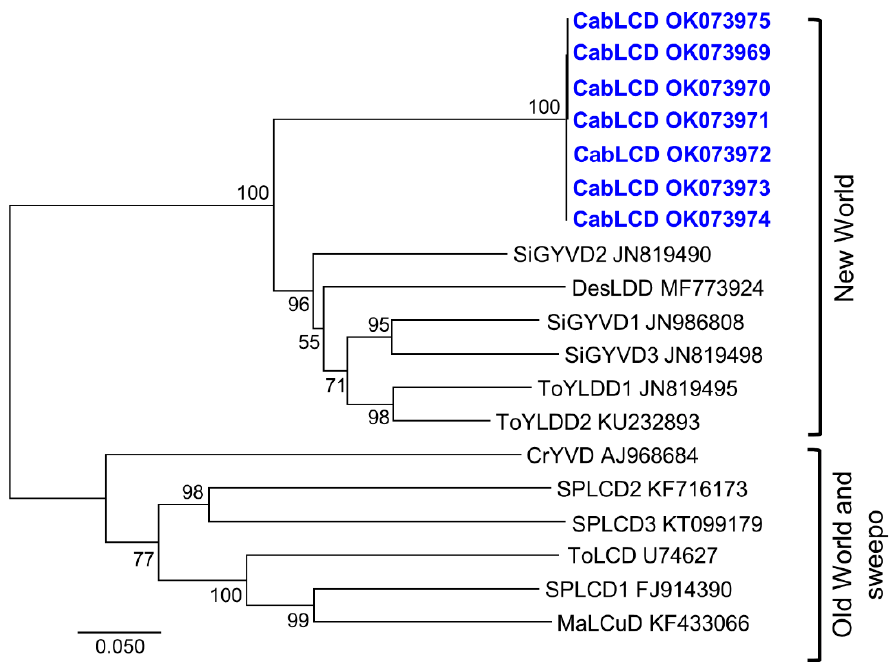
Figure 6. Phylogenetic tree illustrating the relationships of isolates of cabbage leaf curl deltasatellite (CabLCD) (bold in blue) described in this work with representative isolates of other deltasatellite species. The tree was constructed by the neighbor-joining method (1000 replicates) with MEGA 7 [48]. The bar below the tree indicates the number of nucleotide substitutions per site. Major deltasatellite clusters associated with bipartite New World begomoviruses (New World) and monopartite Old World begomoviruses and sweepoviruses (Old World and sweepo) are indicated. Deltasatellite names are in the Figure 4 caption.